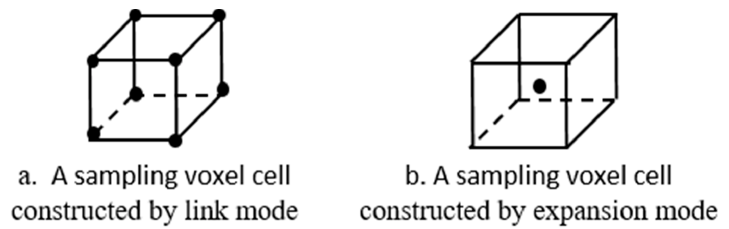
Figure 7. Construction modes of sampling voxel cell. ( a ) A sampling voxel cell constructed by link mode; ( b ) A sampling voxel cell constructed by expansion mode.